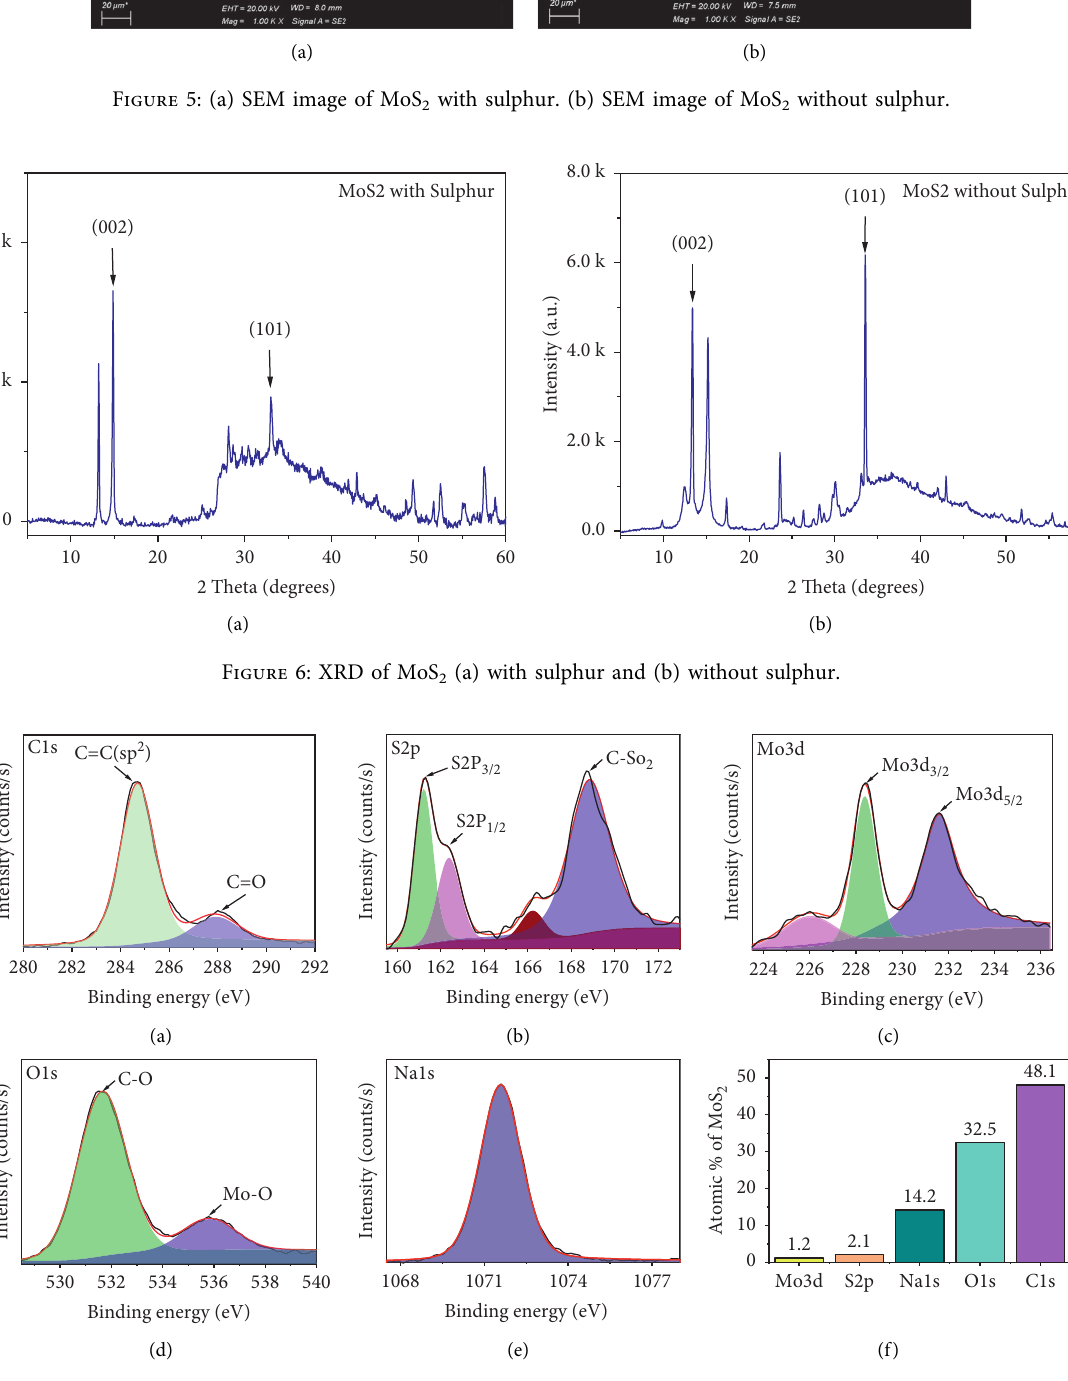
2 P, (c) Mo 3 d, (d) O1s, (e) Na, and (f) atomic